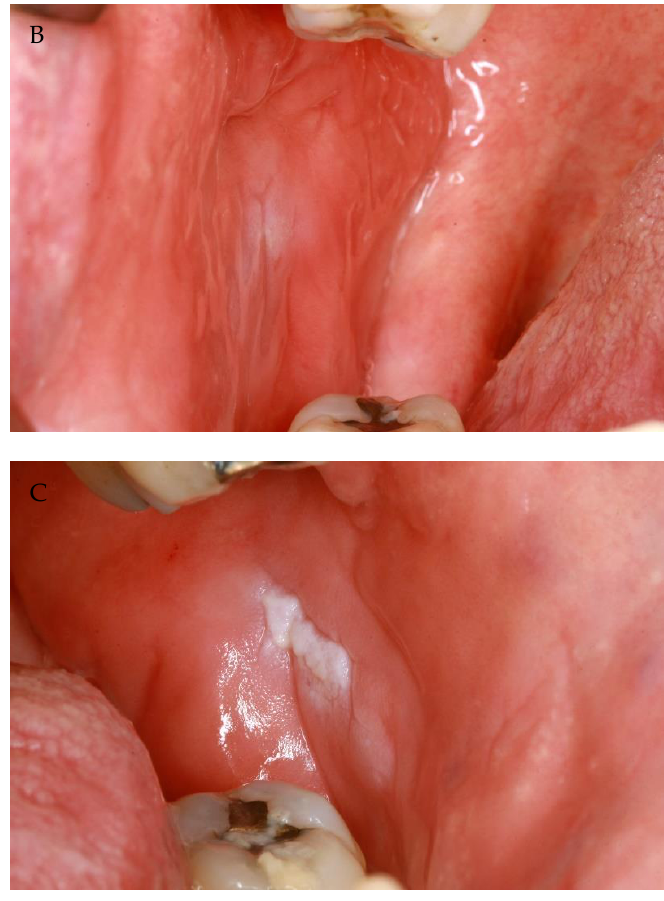
Figure 1. ( A – C ): Fifty-year old male with bilateral whitish papules and plaques of the buccal mucosa, which had appeared nine days after having received a second dose of mRNA-LNP spike protein BNT162b2.